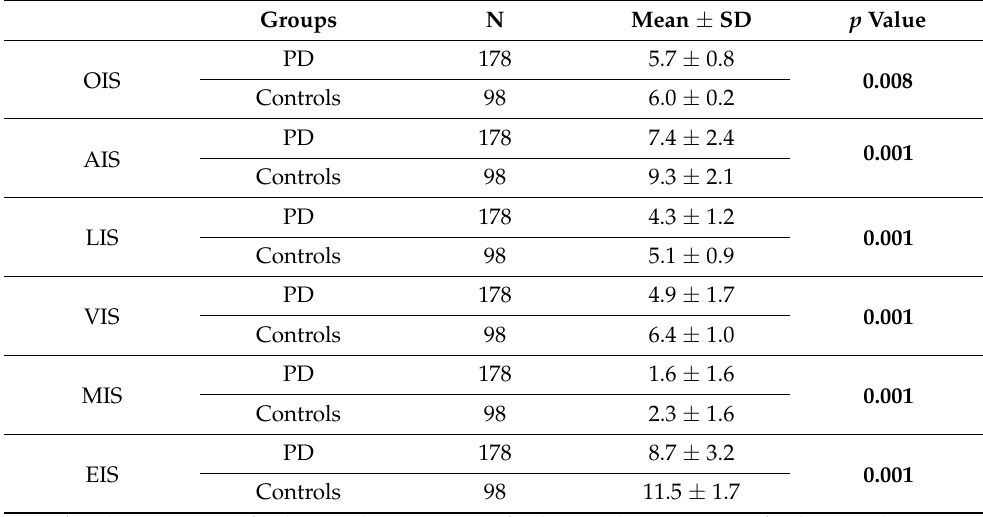
Table 2. Index sub-scores of MoCA representative of specific domains of cognitive dysfunction in PD patients and controls. Data are expressed as mean ±